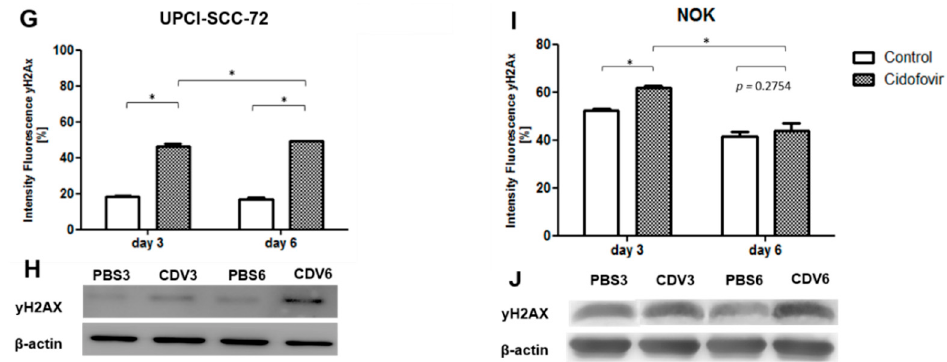
Figure 2. DNA damage induced by CDV as detected by γ -H2AX analysis. Cells were treated with CDV or PBS (control) and after 3 and 6 days immunostaining of γ -H2AX was performed. ( A ) DNA- damage is accumulated in the treated 93-VU-147T cells. Nuclei are stained with Hoechst in blue, DSBs are shown by γ -H2AX in green. ( B ) Quantification of γ -H2AX positive cells after 3 and 6 days